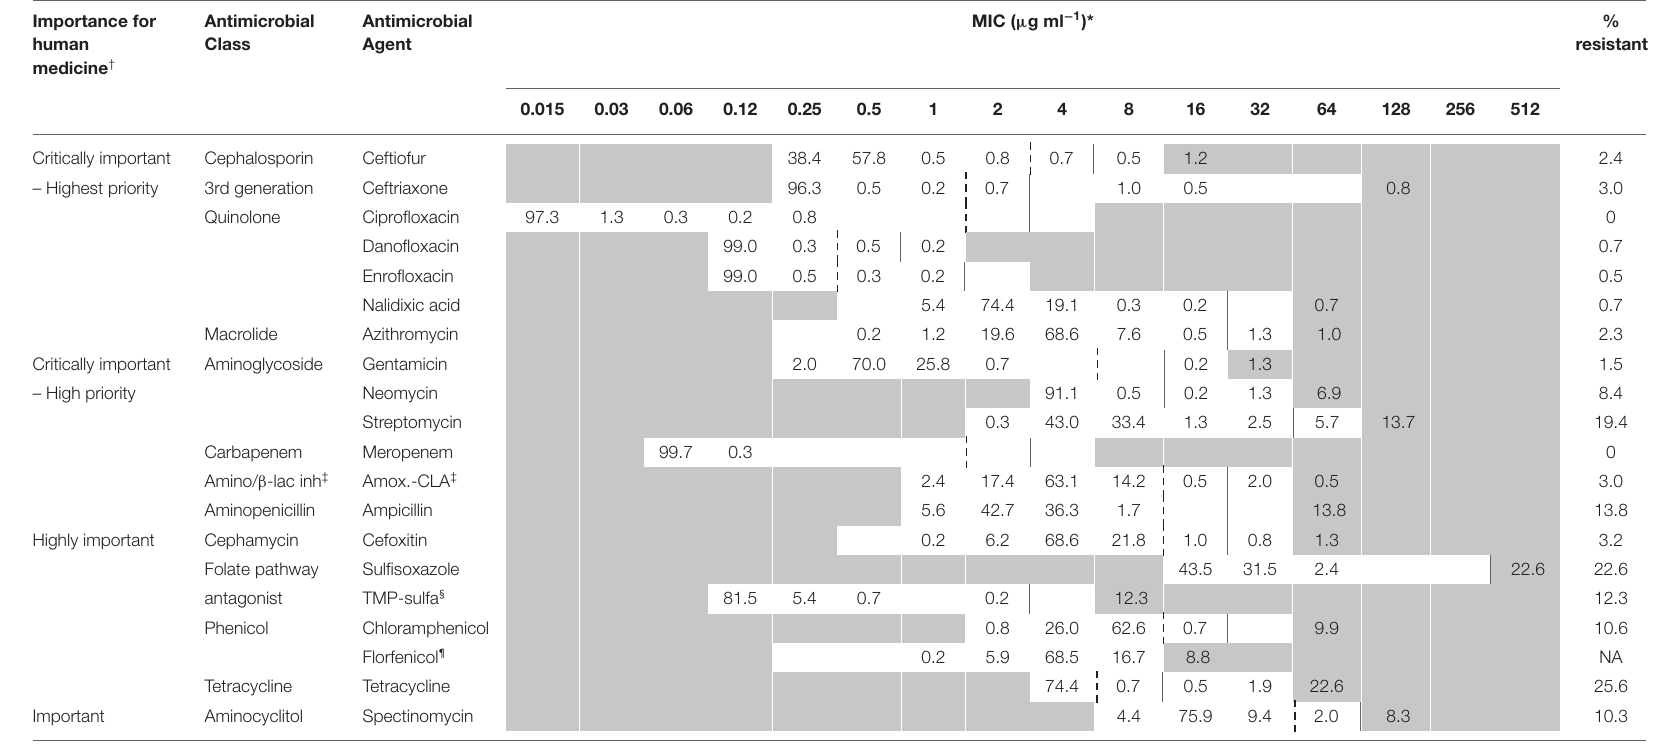
TABLE 1 | Minimum inhibitory concentration for medically important antimicrobials, according to the WHO, of 593 Escherichia coli isolated from calf or cow feces or manure pit of 101 dairy farms in Québec Canada. Importance for human